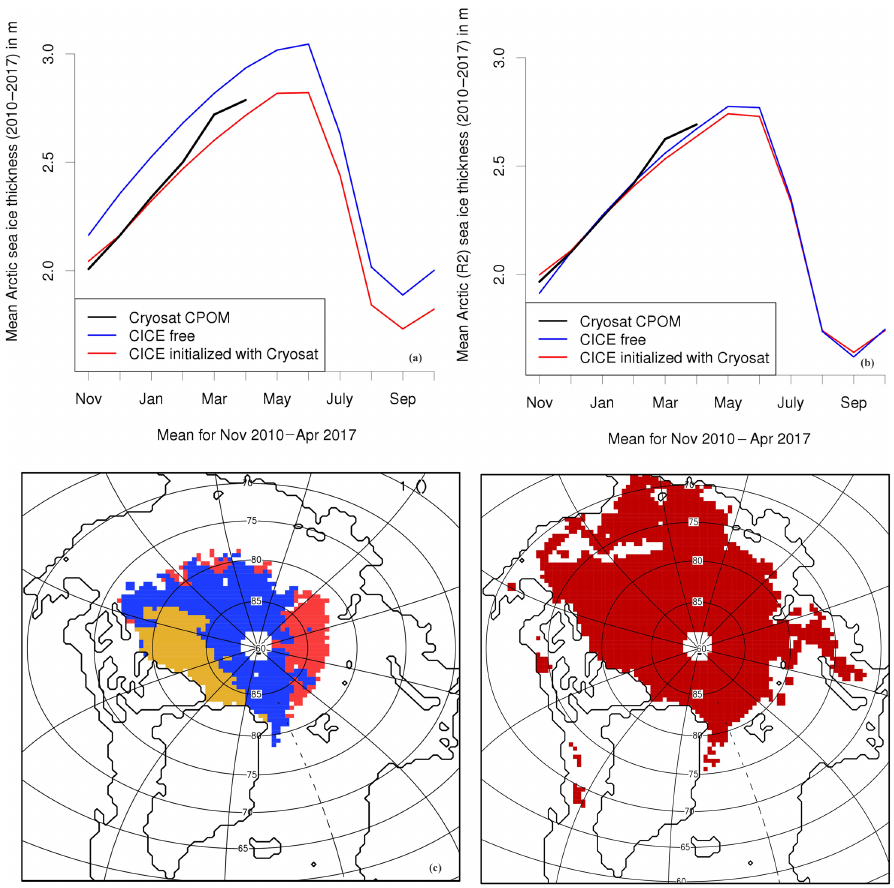
Figure 1. Comparison of CPOM CryoSat-2 mean seasonal sea ice thickness (black) with CICE free (blue) and CICE initialized with Cryosat- 2 in November (red). Panel (a) shows results for mean thickness, averaged over all the colored areas shown in panel (c) , representing the total region for which Cryosat-2 data exist in November (only grid points included with > 100 measurements per month and mean thickness > 0.5m) and (b) mean thickness averaged over the sub-region shown in blue with medium thick ice in January (between 1.5 and 2.5m). Blue areas in panel (c) show regions between November and January where CryoSat-2 thickness are between 1.5 and 2.5m in all years; red for thin ice ( < 1.5) and orange for thick ice ( > 2.5m). Panel (d) is the region over which the April thickness anomalies and results are